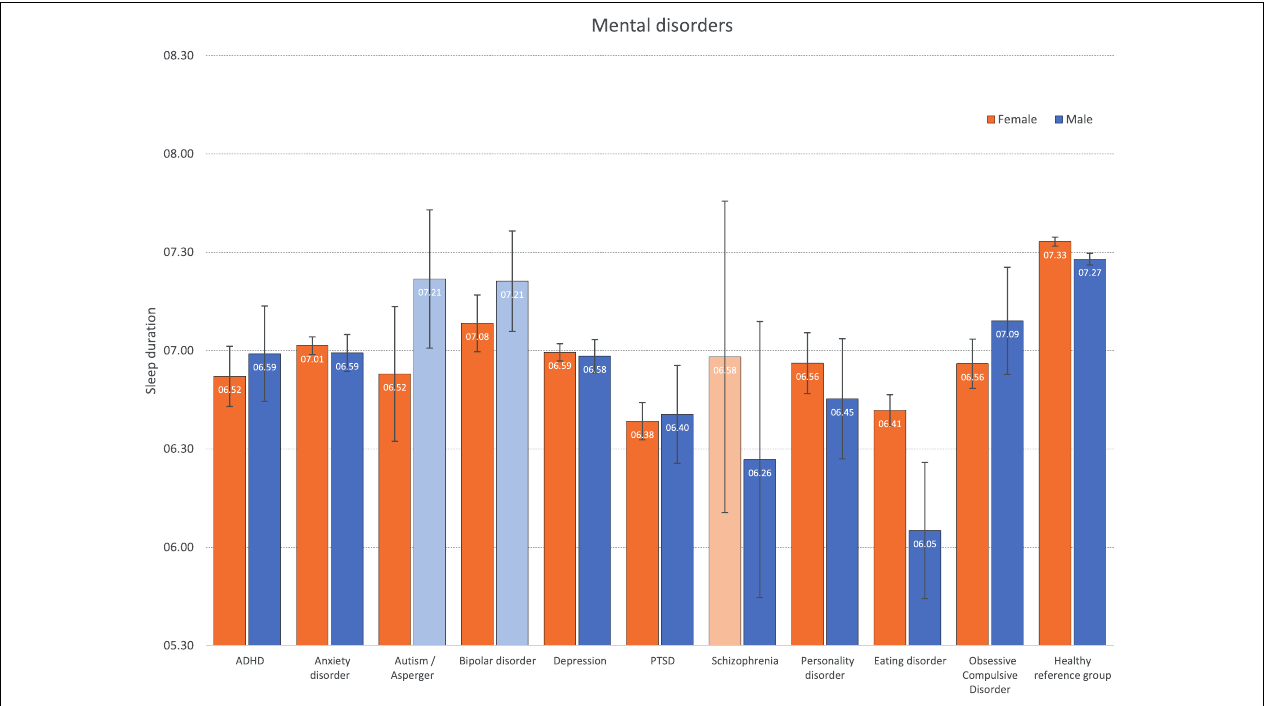
FIGURE 1 | Weekday sleep duration across mental disorders by gender. Bars represent age-adjusted Estimated Marginal Means (EMM), and error bars represent 95% confidence intervals. Light-colored bars represent non-significant differences ( P > 0.05) compared to the healthy reference group within each